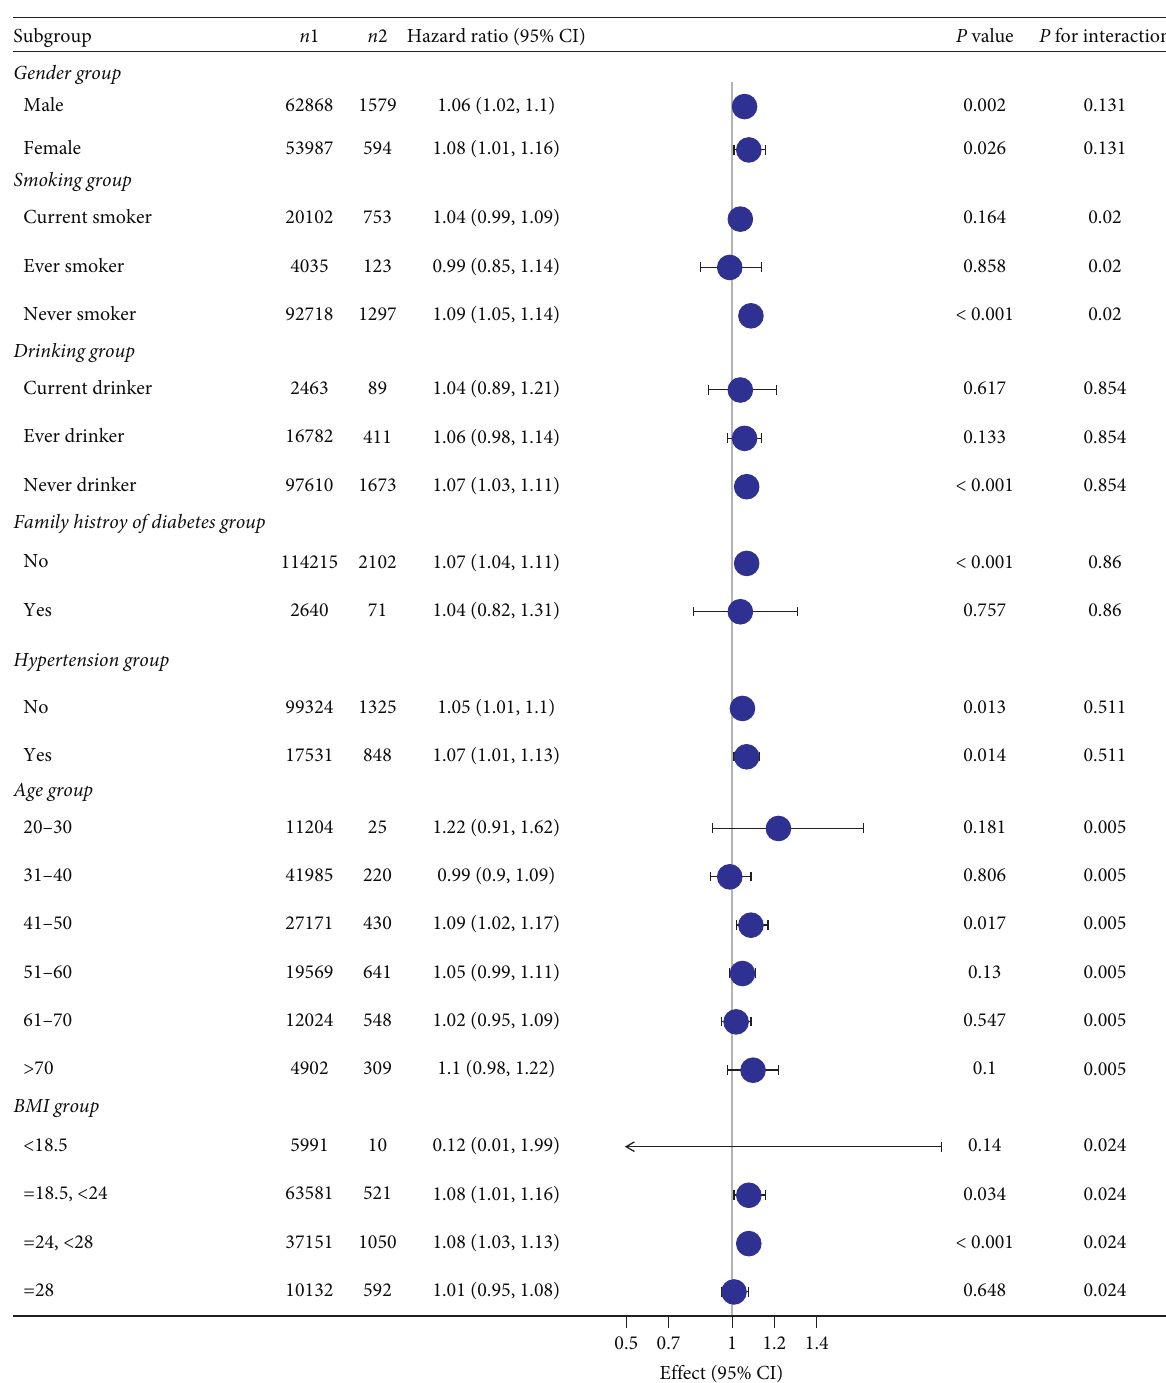
Figure 7: Subgroup analysis of the association between TG/HDL and diabetes